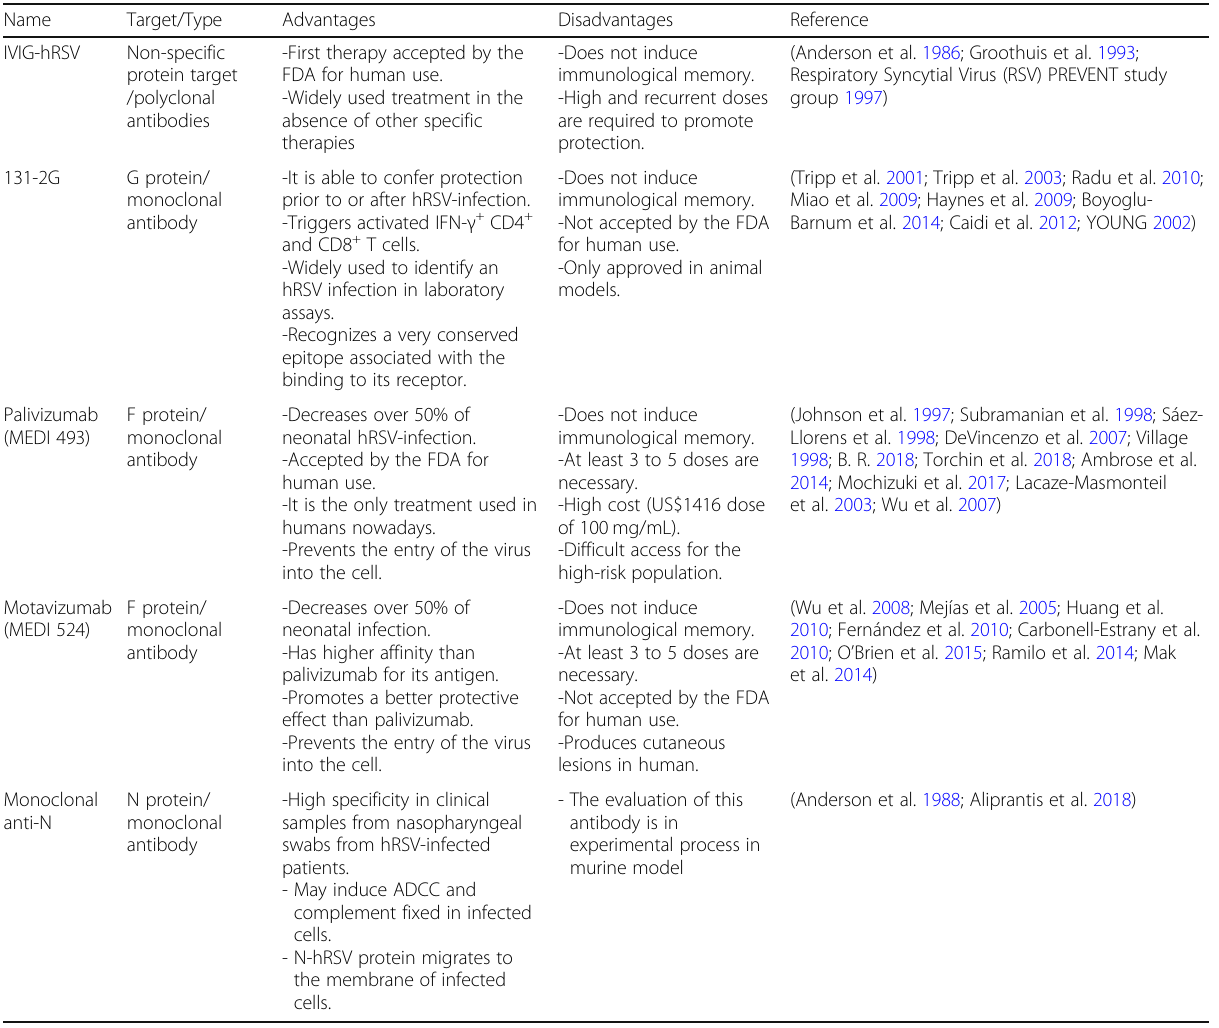
Table 1 Advantages and disadvantages of several antibodies against